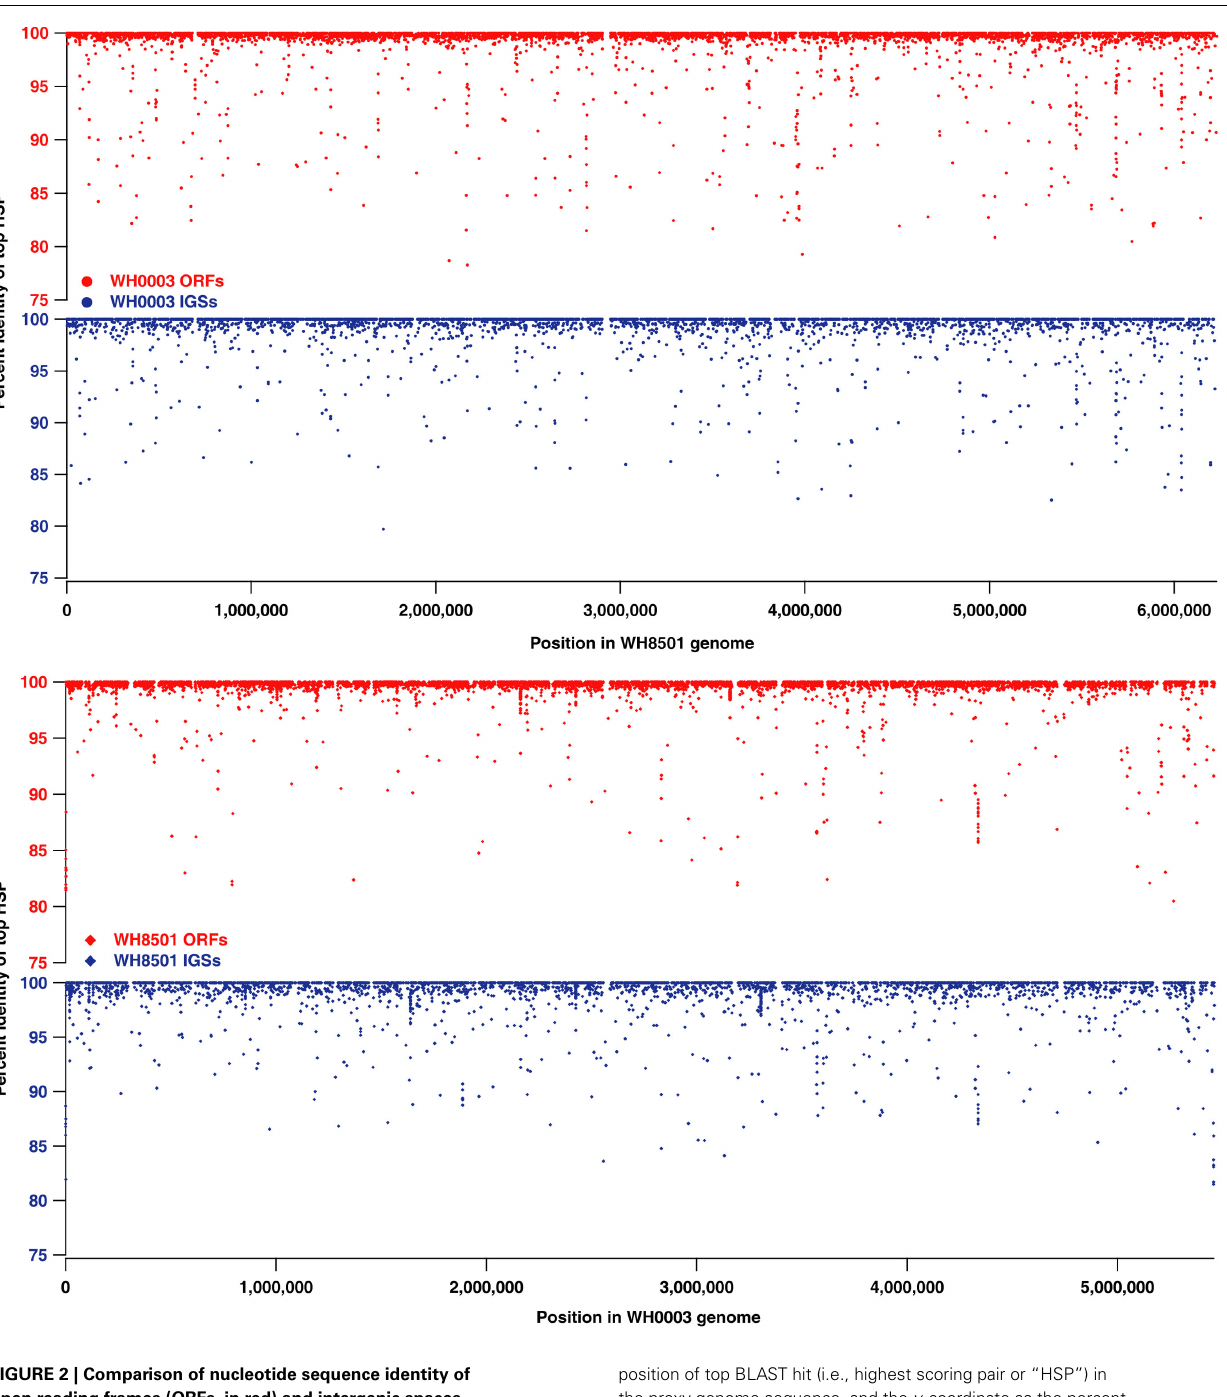
FIGURE 2 | Comparison of nucleotide sequence identity of open reading frames (ORFs, in red) and intergenic spaces (IGSs, in blue) between C. watsonii genomes. Each point represents a single sequence with the x -coordinate as the subject